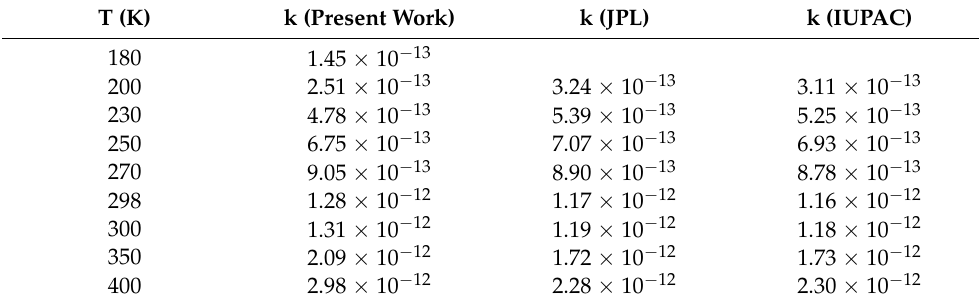
Table 6. Rate coefficients (cm 3 molecule − 1 s − 1 ) for the reaction of O 3 with Br at the MRCI + Q/ aug-ano-RCC-VTZP//MP2/aug-cc-pV(T + d)Z levels of theory using CVT/SCT along with the recommended rate coefficients by NASA/JPL [13] and IUPAC [51] for